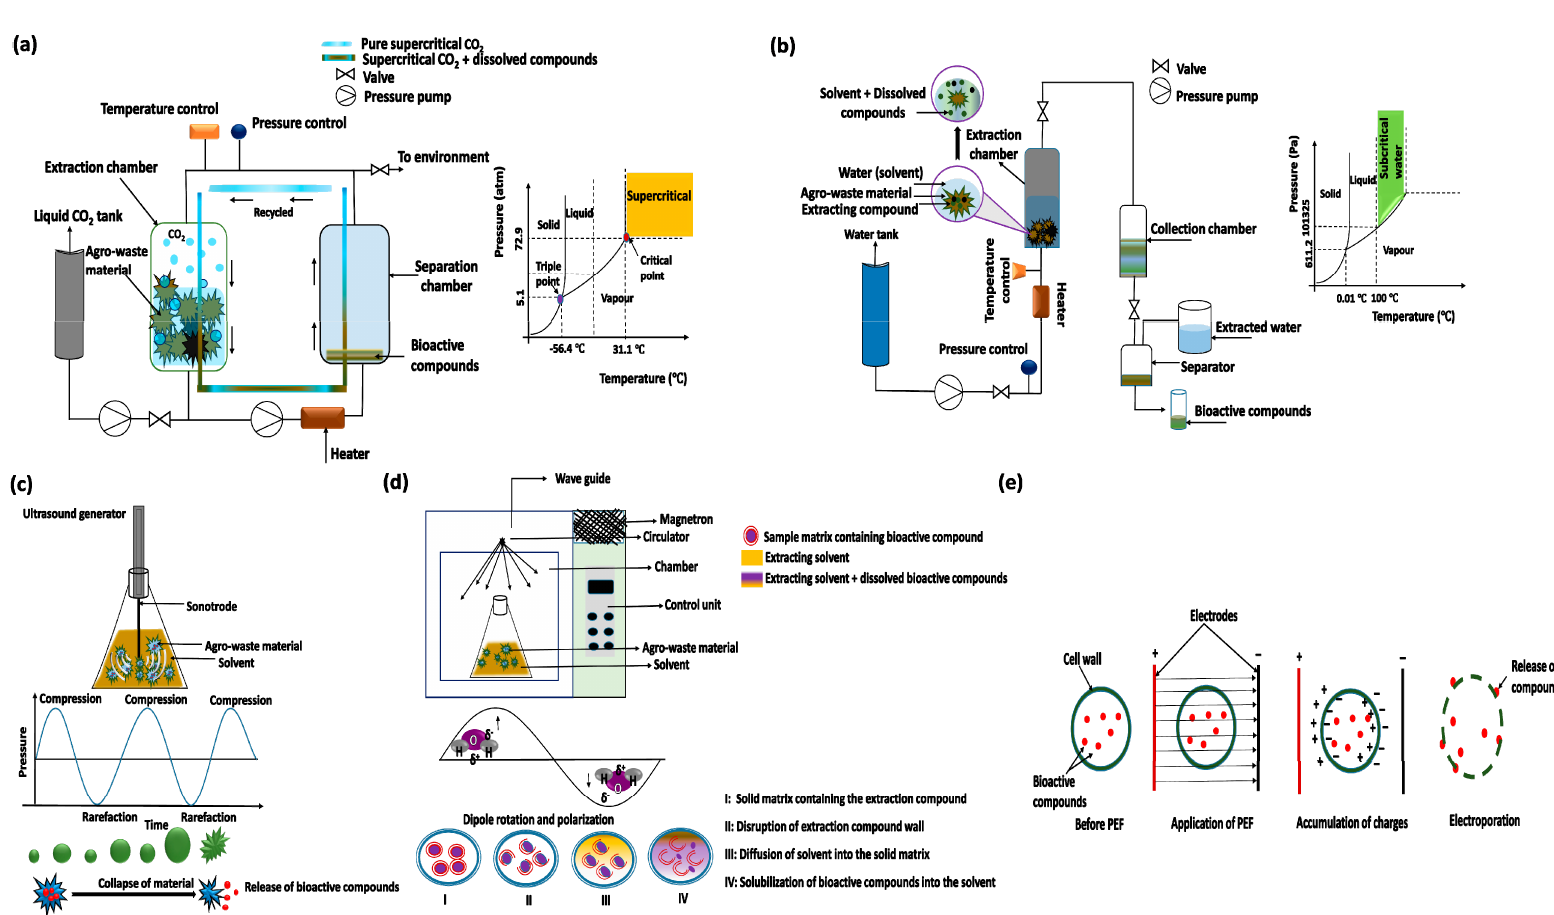
Figure 2. Schematic illustration of extraction techniques, ( a ) supercritical fluid extraction; ( b ) subcritical water extraction; ( c ) ultrasonic assisted extraction; ( d ) microwave assisted extraction; ( e ) pulsed electric field extraction.